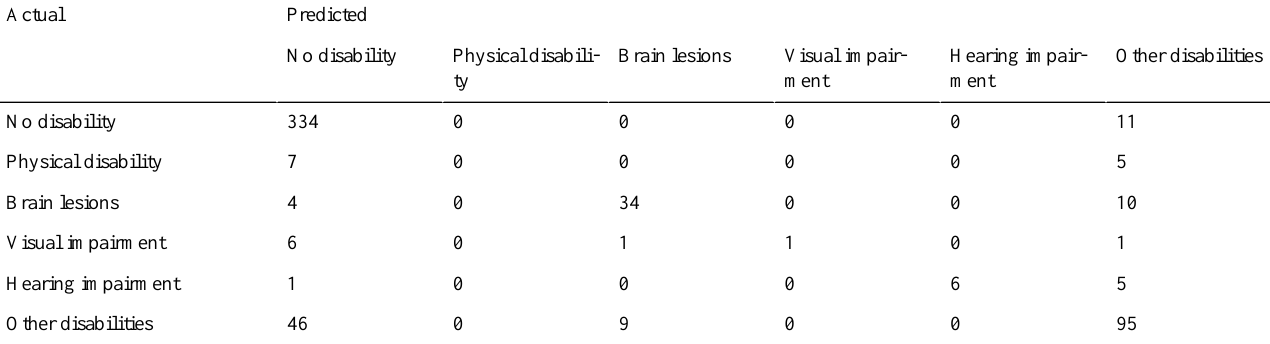
Table 5. Confusion matrix when using only disease diagnostic data.